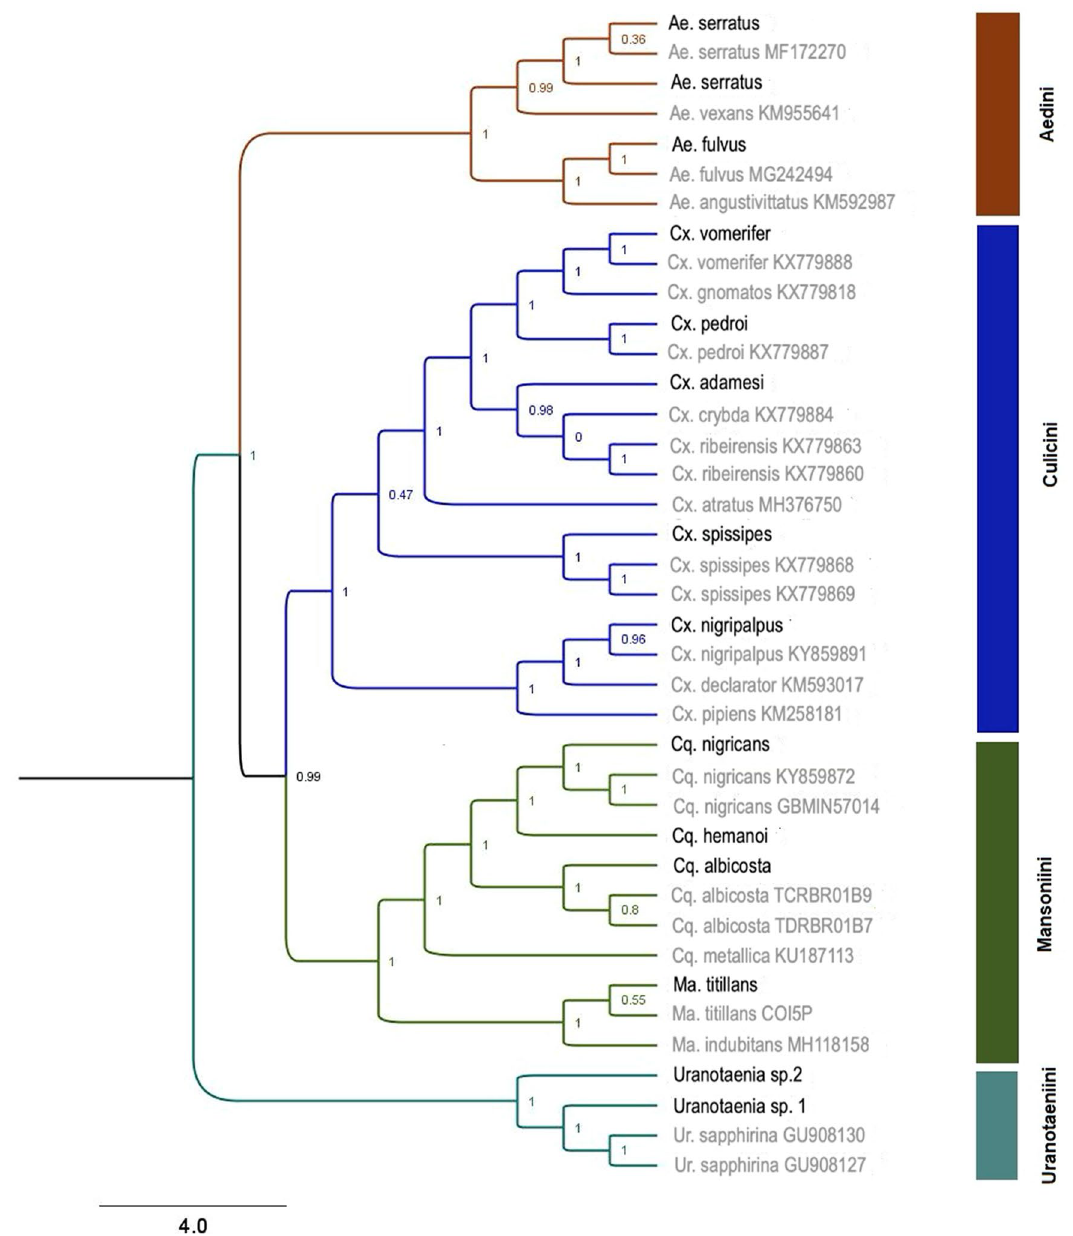
Figure 1. Maximum likelihood phylogenetic reconstruction based on COI sequences deposited in GenBank and our original data for the species of the family Culicidae: The reference sequences are gray, and the sequences generated in this work are black. SH ‐ like branch support is depicted above or in front of the corresponding nodes. The aLRT branch support is shown with ≤ two decimals. Branches are highlighted by Tribe